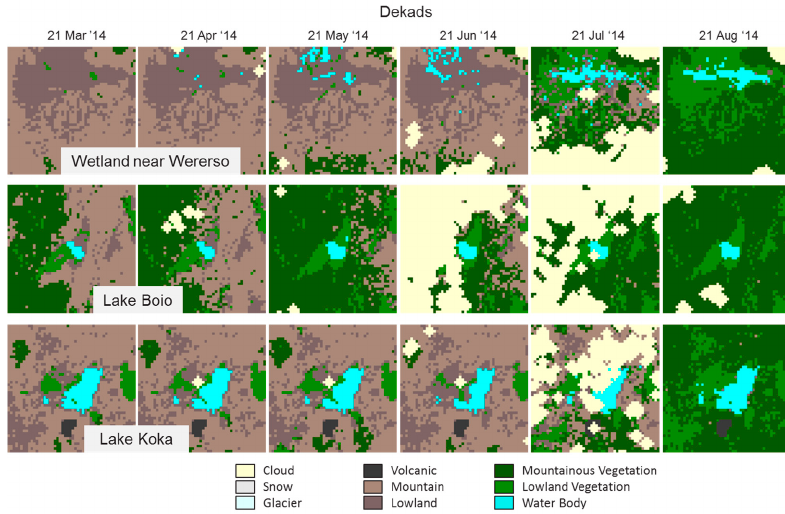
Figure 13. Water body evolution for three WBs in the Rift Valley, the wetland near Wererso (Centre: 8 ◦ 52 (cid:48) 46”N, 38 ◦ 22 (cid:48) 46”E), Lake Boio (Centre: 7 ◦ 30 (cid:48) 48”N, 38 ◦ 2 (cid:48) 24”E) and Lake Koka (Centre: 8 ◦ 23 (cid:48) 50”N, 39 ◦ 4 (cid:48) 33”E). The water bodies grow in size during the rainy season, which peaks in the months July and August.